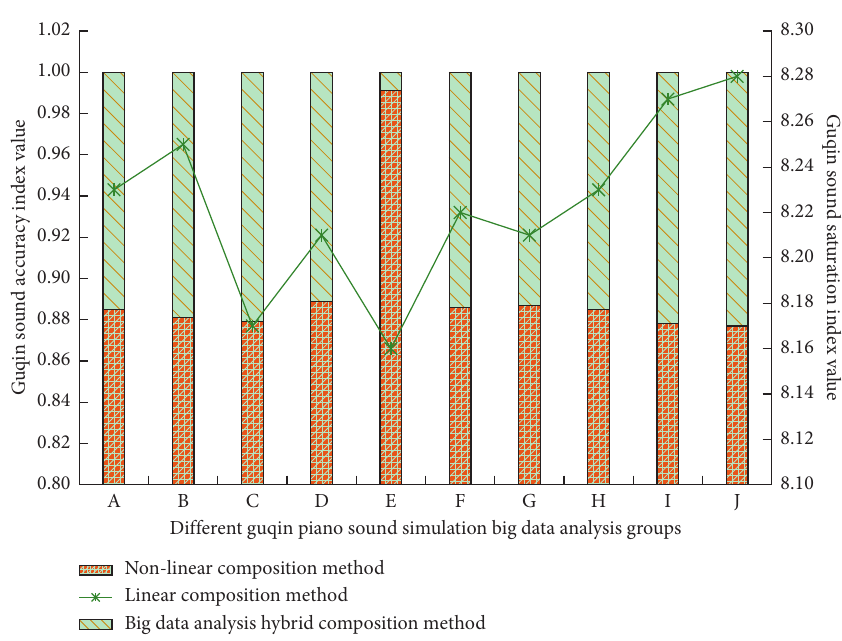
Figure 3: Comparison of accuracy results obtained by different test